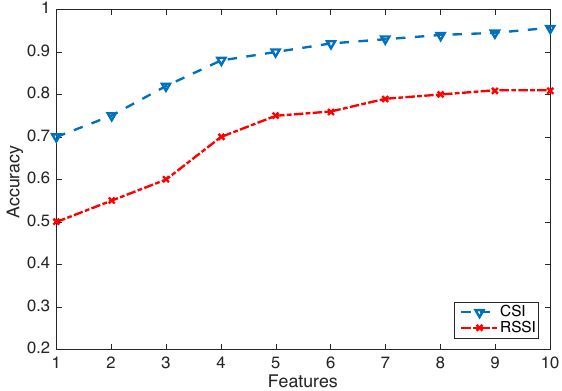
Figure 8. Channel State Information (CSI) vs. Received Signal Strength Indicator (RSSI) in an LOS